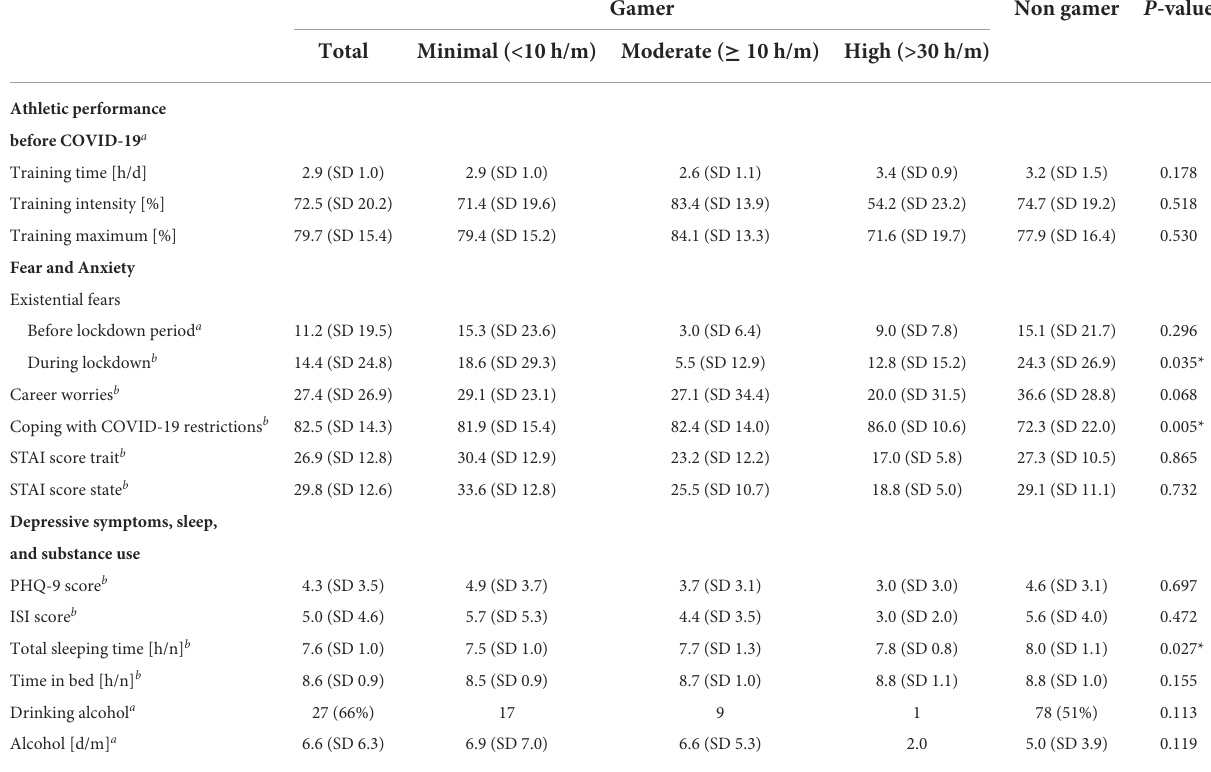
TABLE 2 Athletic performance, fears, depressive symptoms, and sleep behavior in professional athletes who gamed regularly before the